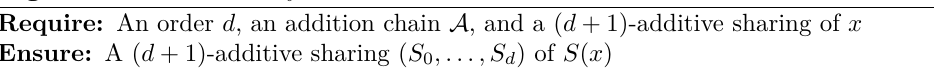
Algorithm 7 Alternate